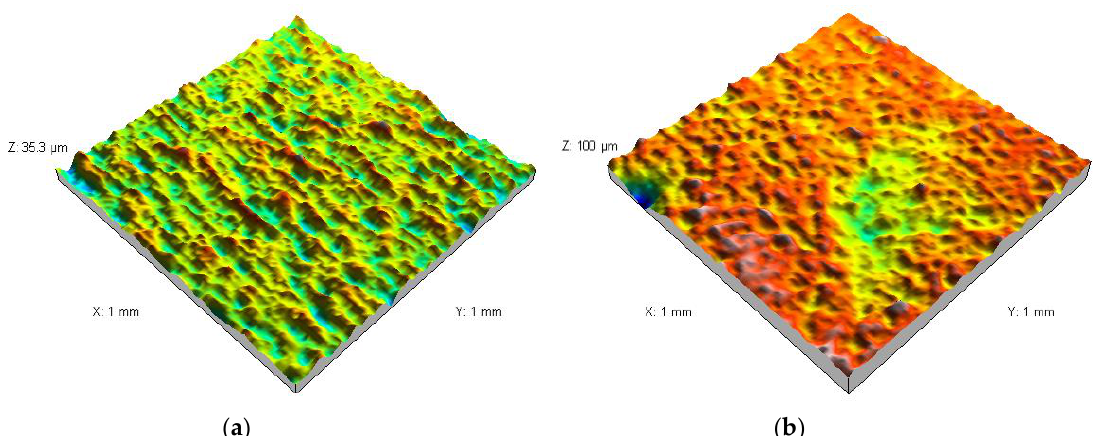
Figure 7. Representative profile lines for the reference material (PE) ( a ) and biofilm coated material ( b ).